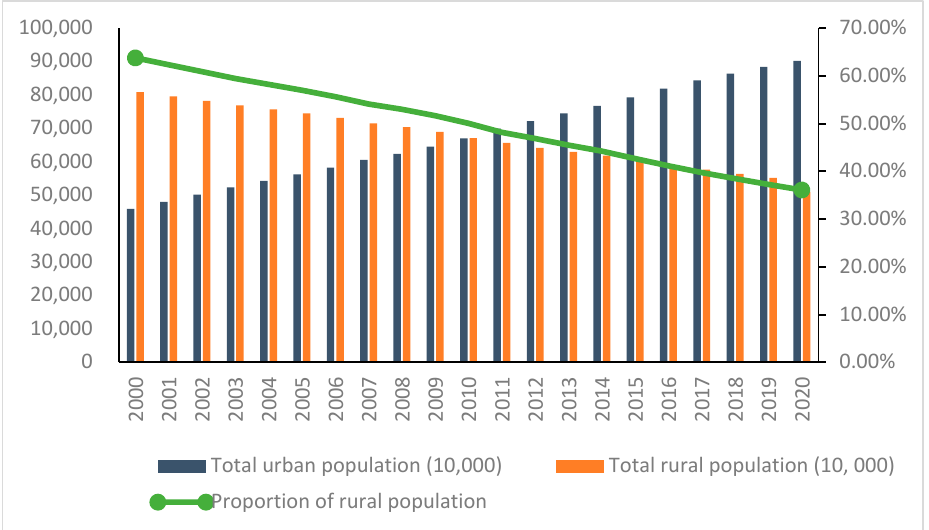
Figure 2. Urban and rural population changes in China from 2000 to 2020. (Data from the Seventh National Census Bulletin of National Bureau of Statistics of China).